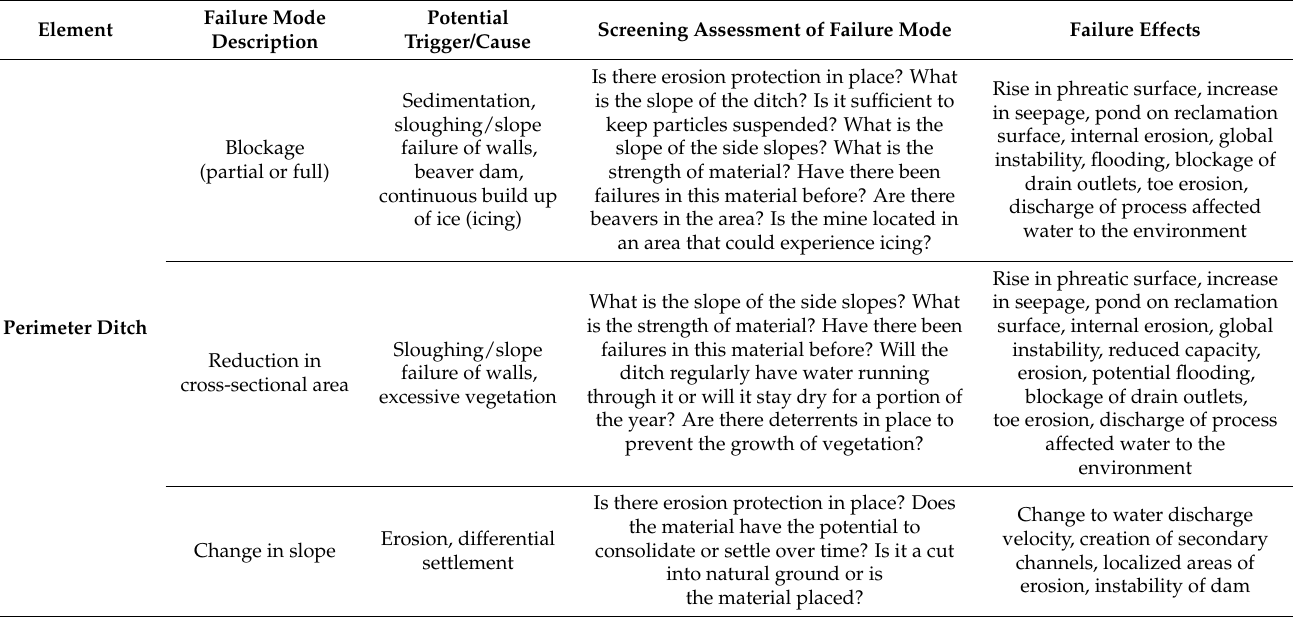
Table 2. Excerpt from drainage element G-FMEA